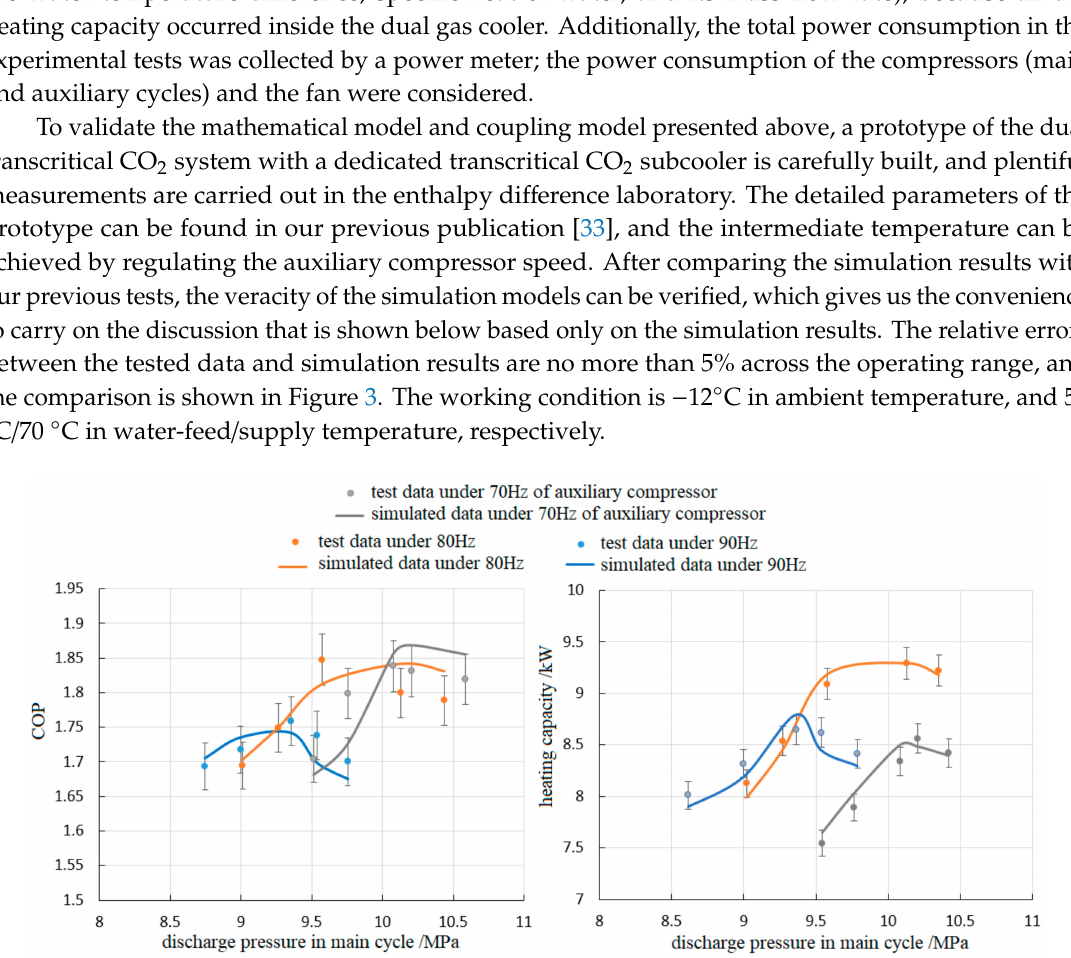
Figure 3. The comparison between simulation and experiment